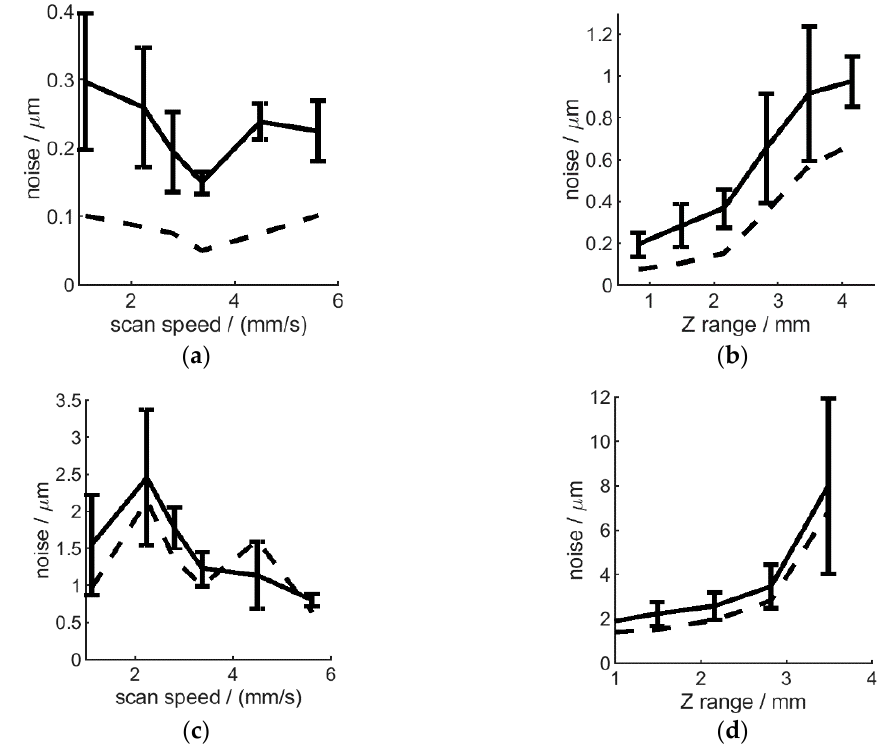
Figure 7. Influence of scan speed ( a , c ) and range ( b , d ) on noise level. The H6 was mounted on a stable H-frame ( a , b ) or on a fully extended robot arm ( c , d ). The mean (solid line) and standard deviation (shown by the error-bars) are shown together with the noise error of the averaged surface (dashed line). Highest Z resolution and R5 optics used.